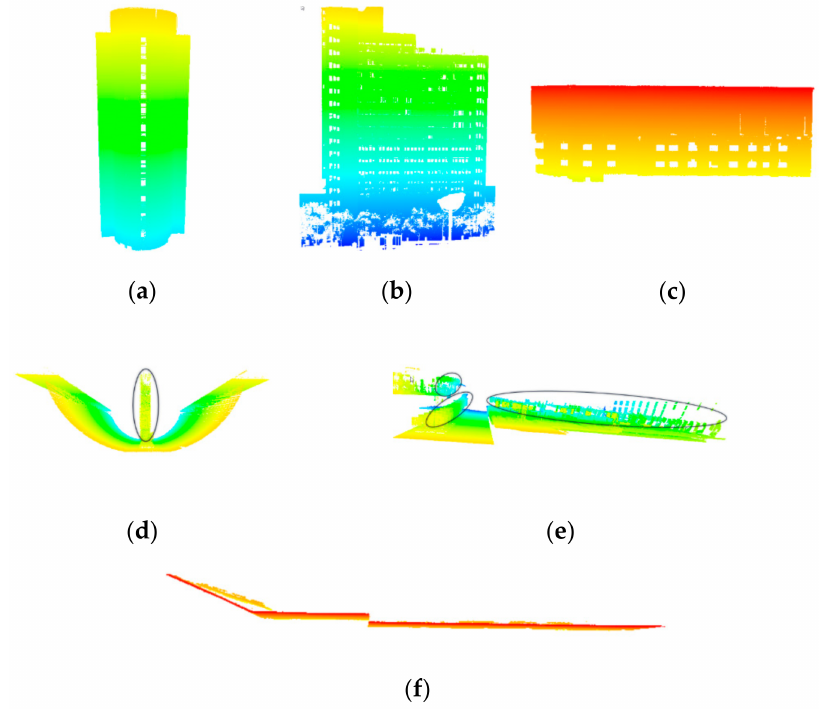
Figure 14. Facades recognized at the last step of the decision tree. ( a – c ) show the side view and ( d – f ) show the top view. The points marked by the ellipses in ( d , e ) are indoor points.